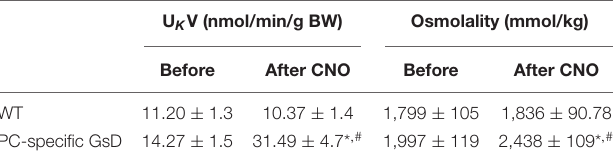
TABLE 1 | Urinary potassium excretion (U K V) and osmolality in PC-specific GsD